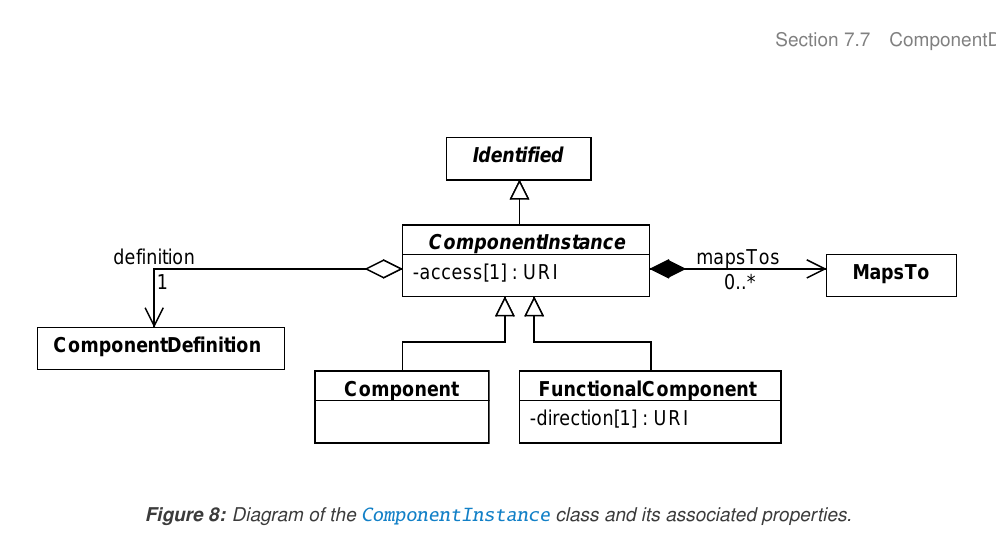
Figure 8: Diagram of the ComponentInstance class and its associated